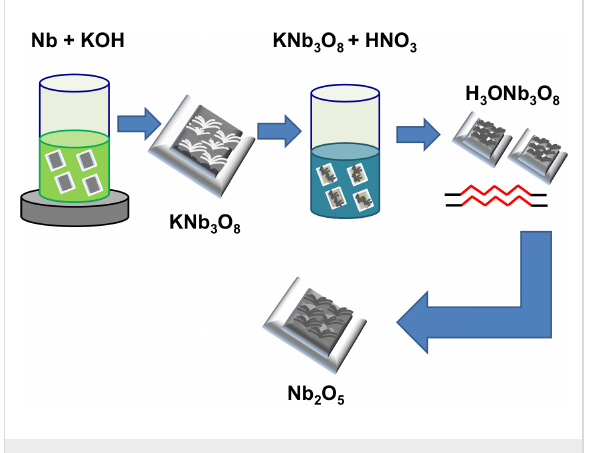
Figure 16: Flow chart describing the synthesis process for niobium oxide nanostructures by hydrothermal treatment.